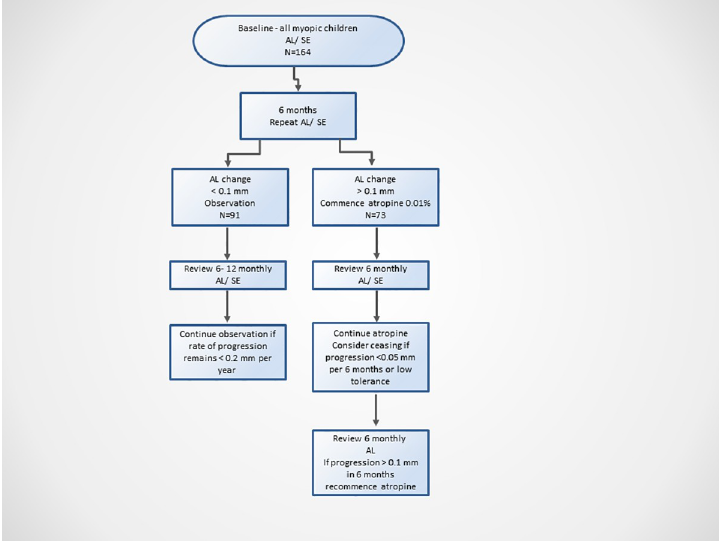
Fig 1. Participation flowchart in atropine 0.01% study. Legend: AL = axial length, SE = spherical equivalent.